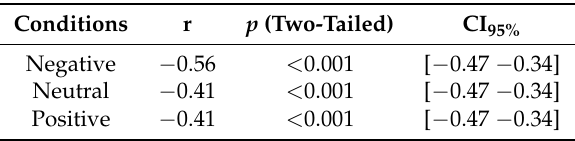
Figure A5. Bootstrap Spearman correlation test (10,000 simulation runs) at 95.0% confidence interval between participants’ DEs (i.e., 62 DEs associated with 62 EEG channels of a participant, per affect) and their corresponding MSE20 values (i.e., 62 MSE20s associated with 62 EEG channels of a participant, per affect) in ( A ) negative, ( B ) neutral, and ( C ) positive. MSE20 was significantly anti-correlated with DE in the negative, neutral, and positive states. Overall, MSE20 anti-correlations were stronger than MSE1 in every mental state. Table A5. Bootstrap (10,000 simulation runs) 95.0% confidence intervals (CI) associated with the Spearman correlation between MSE20s (i.e., 62 MSE20s associated with 62 EEG channels of a participant, per affect) and DEs (i.e., 62 DEs associated with 62 EEG channels of a participant, per affect) in the negative, neutral, and positive mental